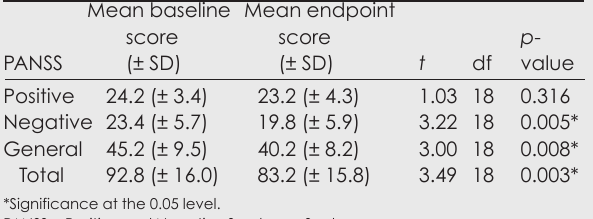
Table I. Change in PANSS total and subscale scores over 8 weeks